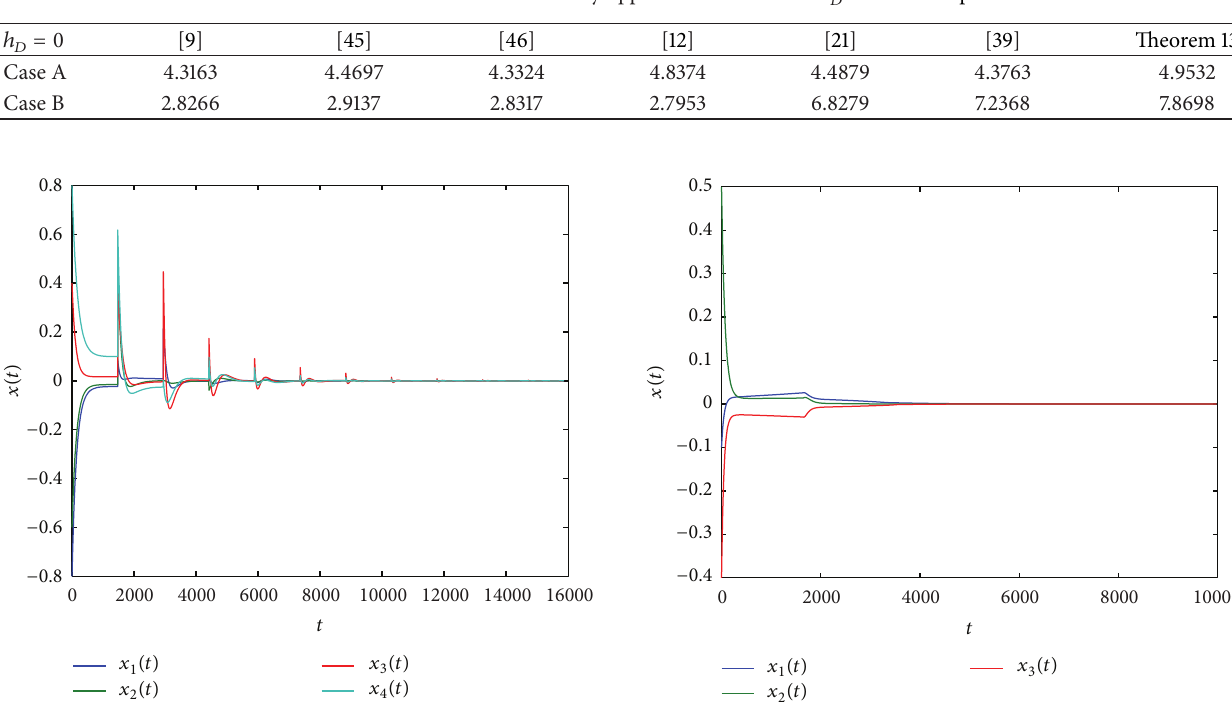
Table 3: Maximum allowable time-delay upper bounds ℎ = 𝑟 for ℎ 𝐷 = 0 in Example 2.